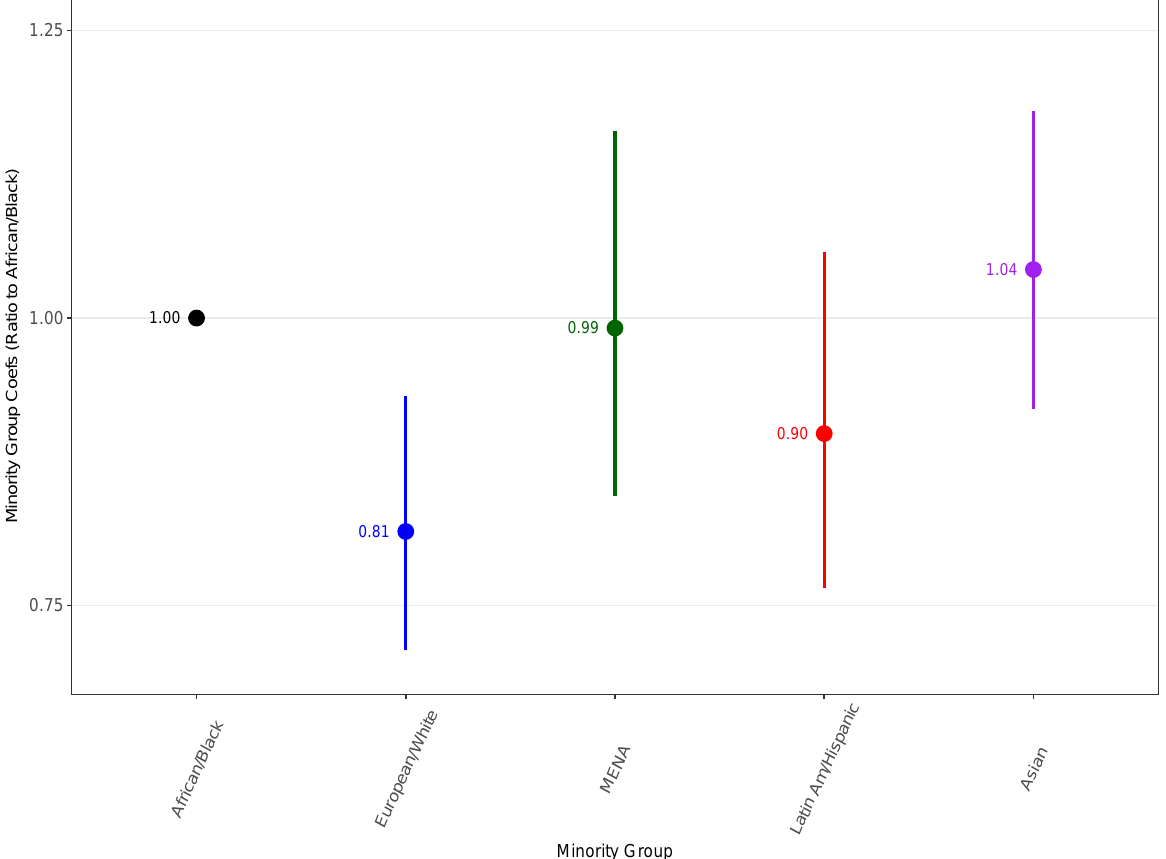
Figure 3: Minority Group Discrimination Levels Relative to African/Black